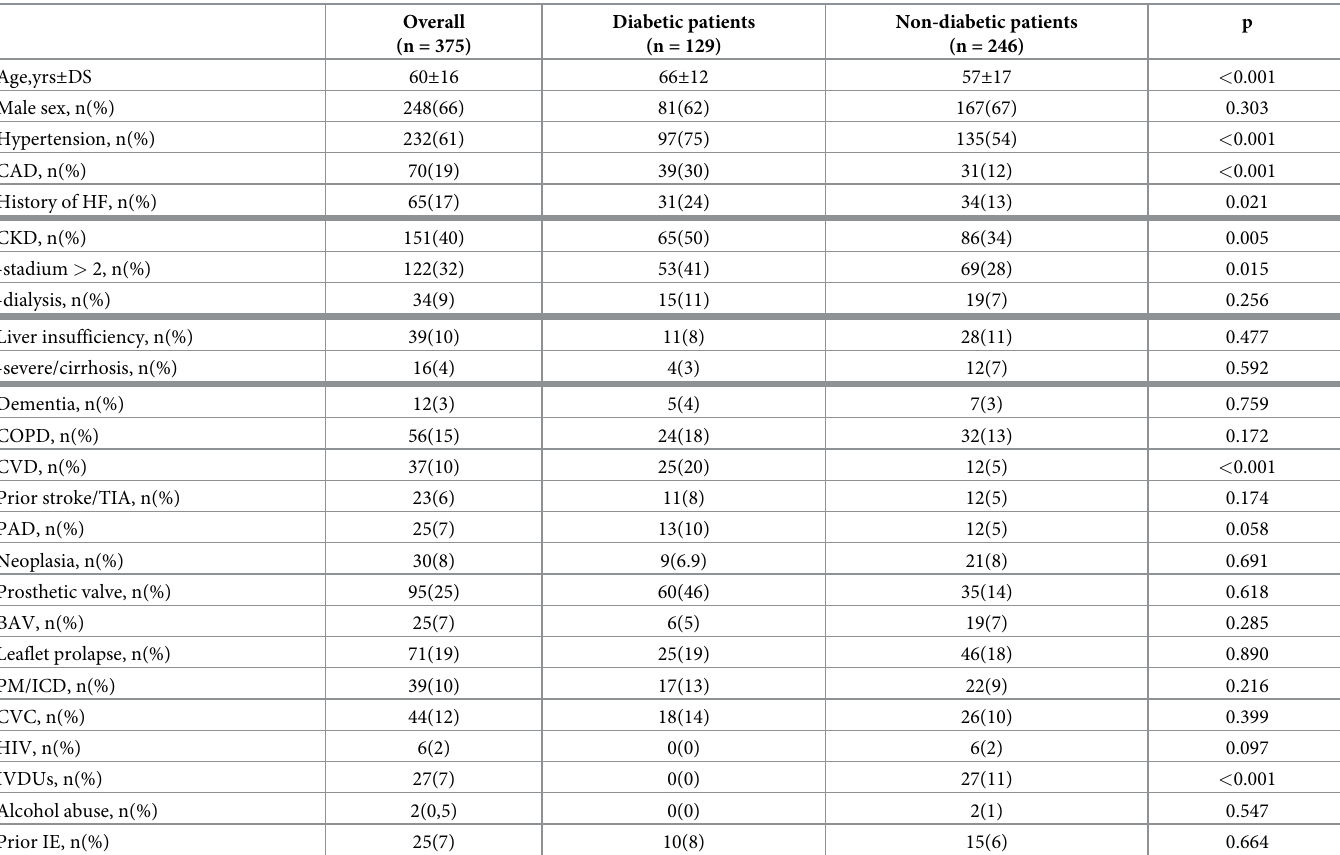
Table 1. Clinical characteristics of the study population.